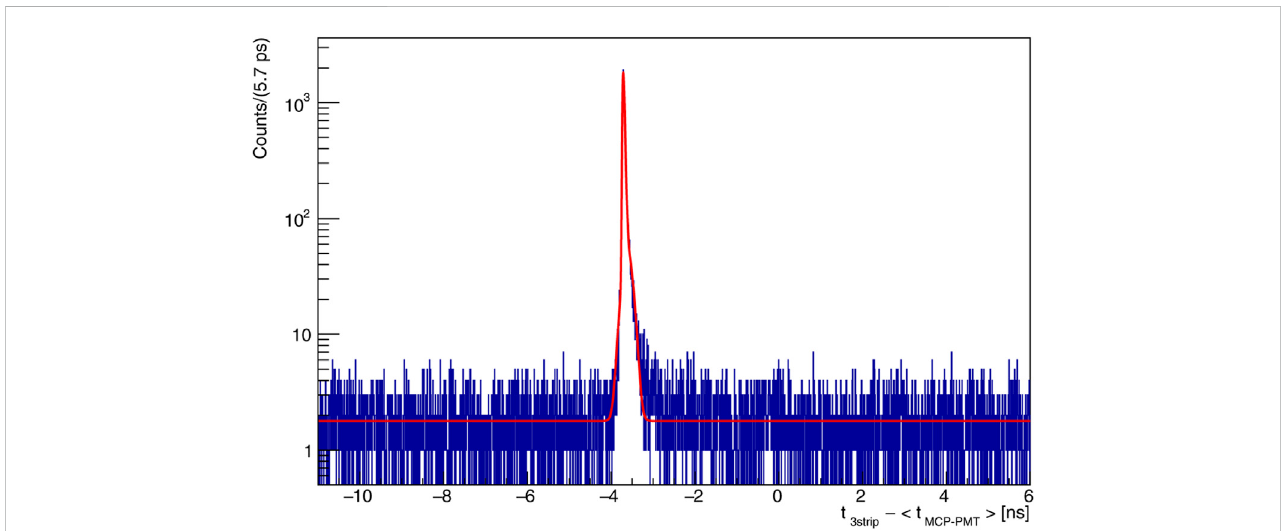
FIGURE 6 DistributionofthedifferencebetweentheTOAofthetriplestripandthetimereference, t 3strip — 〈 t MCP-PMT 〉 ,forthetriggeredtrackswithaminimumpulse height both in the pixel and in the MCP-PMTs in a time window of ±200 ps around the expected time difference t pixel − 〈 t MCP-PMT 〉 , N trig . The detected tracks populate the peaking structure around − 3.5 ns, while the undetected tracks are uniformly distributed. The red curve represents the result of the fi t to the